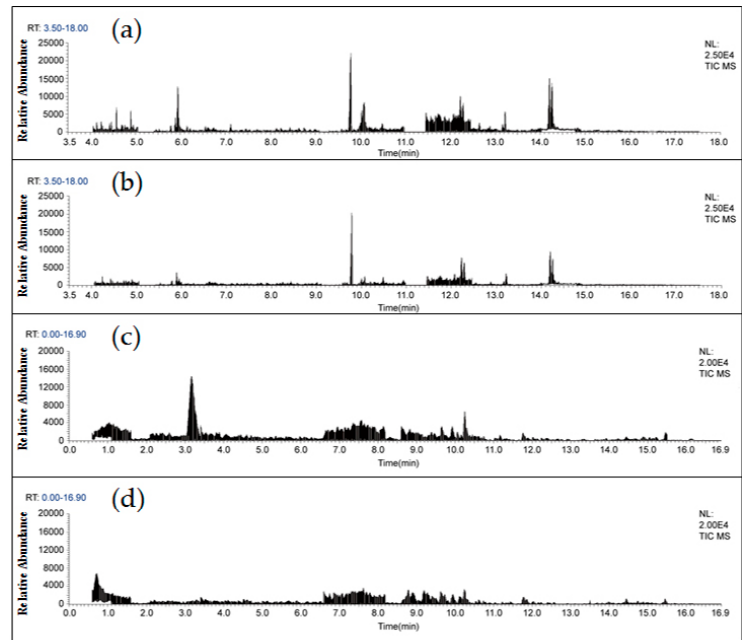
Figure 3. Total ion chromatograms (TIC) for a blank lettuce extract with different cleanup procedures. ( a ) TIC of GC–MS/MS with d-SPE cleanup, ( b ) TIC of GC–MS/MS with Sin-QuEChERS nano cleanup, ( c ) TIC of LC–MS/MS with d-SPE cleanup and ( d ) TIC of LC–MS/MS with Sin-QuEChERS nano cleanup.